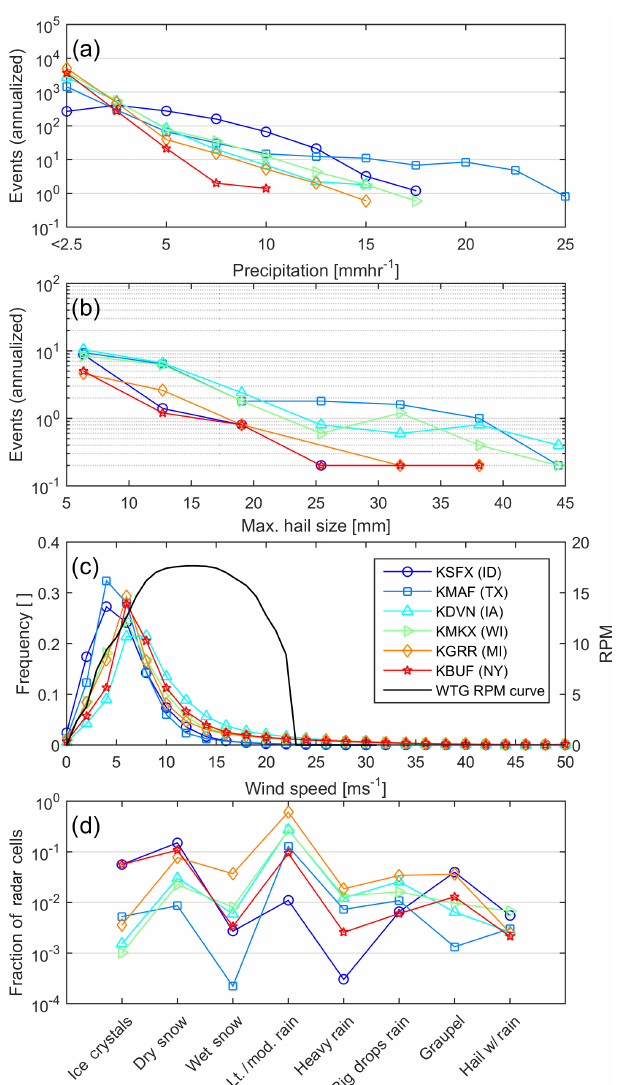
Figure 4. Precipitation and wind speed climates from radar data (see locations in Fig. 1). (a) Mean annual number of 5min periods of each RR intensity class (discretized in 5mmh − 1 intervals). (b) Mean annual number of 5min periods with maximum hail sizes ( D 75 ) (discretized in 5mm intervals). (c) Wind speed distributions for all 5min periods (discretized in 2ms − 1 intervals). The black line in this frame shows the WT RPM curve as a function of wind speed (WTG RPM, right axis) (d) . Occurrence of NWS radar hydrometeor classifications for each nominal wind farm shown as the fraction of radar cells in each class during all periods with RR > 1mmh − 1